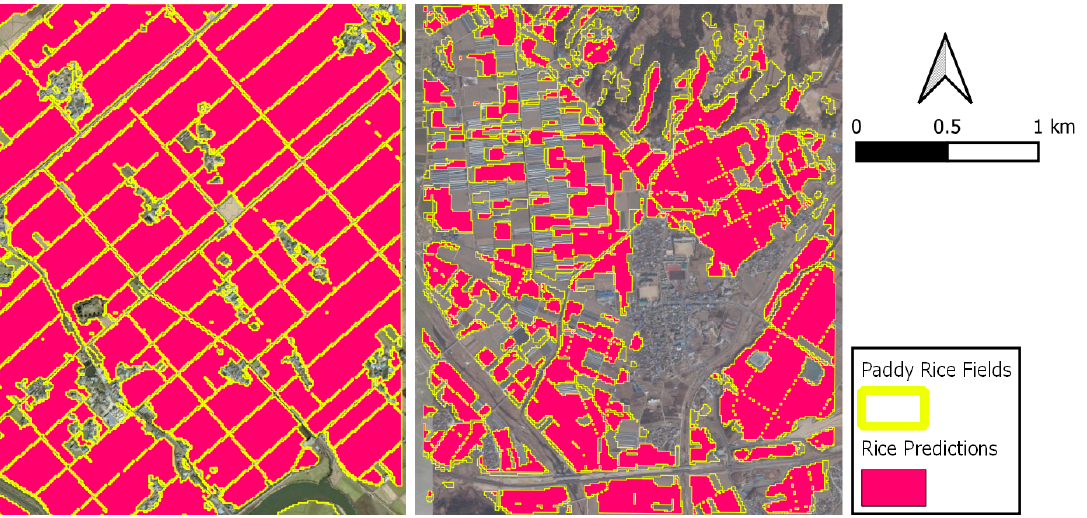
Figure 18. Paddy rice prediction maps for E ( left ) and G ( right ) test